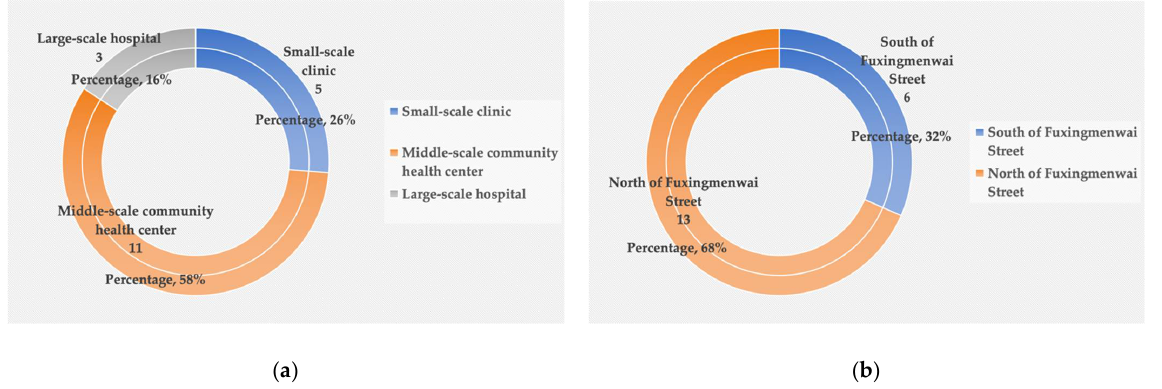
Figure 3. Density of healthcare facilities: ( a ) number of each type of healthcare facility; ( b ) spatial distribution of healthcare facilities.